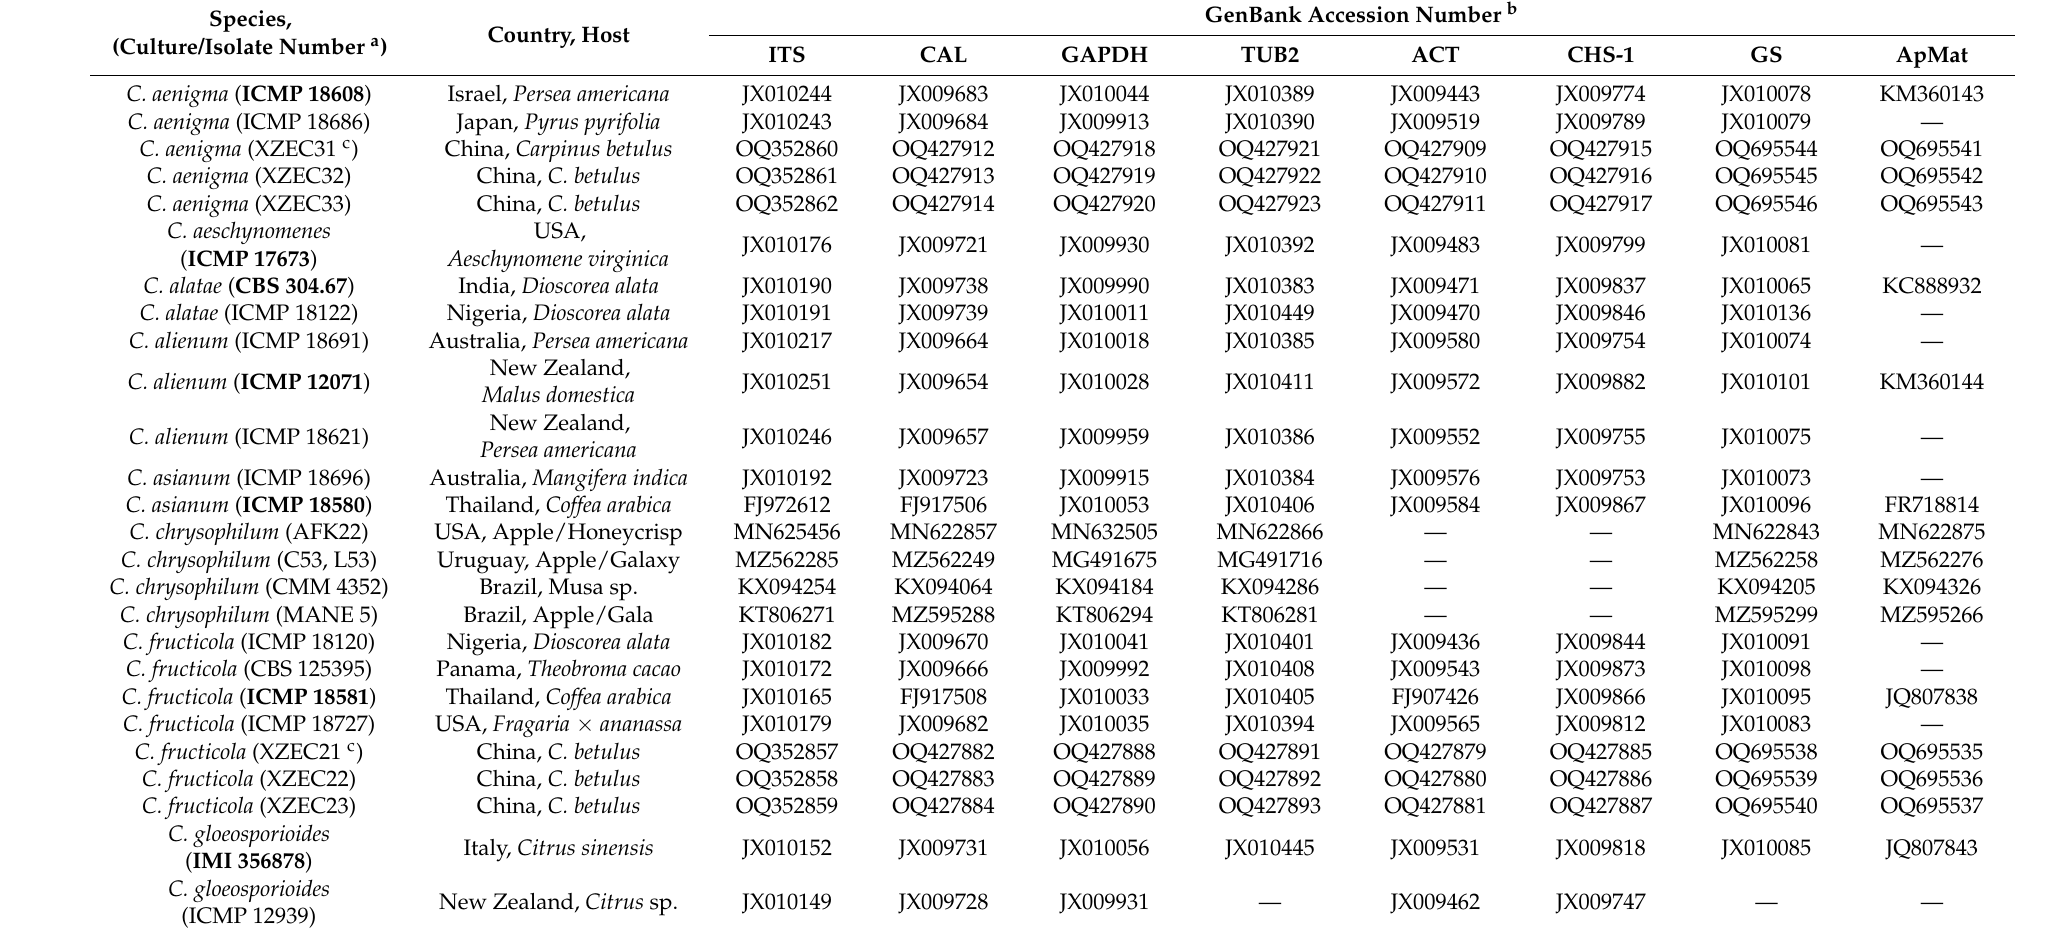
Table 3. Sequences of Colletotrichum species used in this